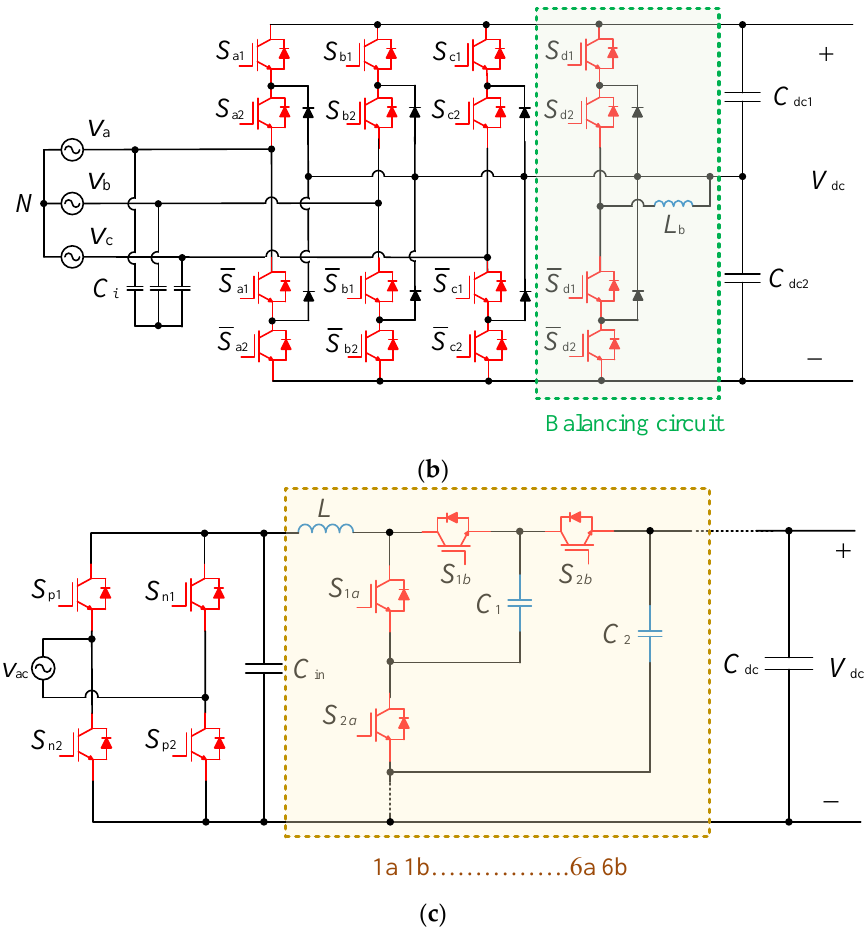
Figure 12. Multilevel converters (MLCs) used as grid-interfaced converter: ( a ) Cascaded H-Bridge (CHB), ( b ) Neutral Point Clamped (NPC), and ( c ) Flying Capacitor (FC).